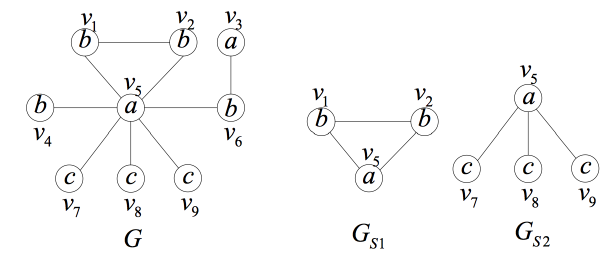
Figure 3. An example of the Smallest Unique Induced Subgraph (SUIS) and